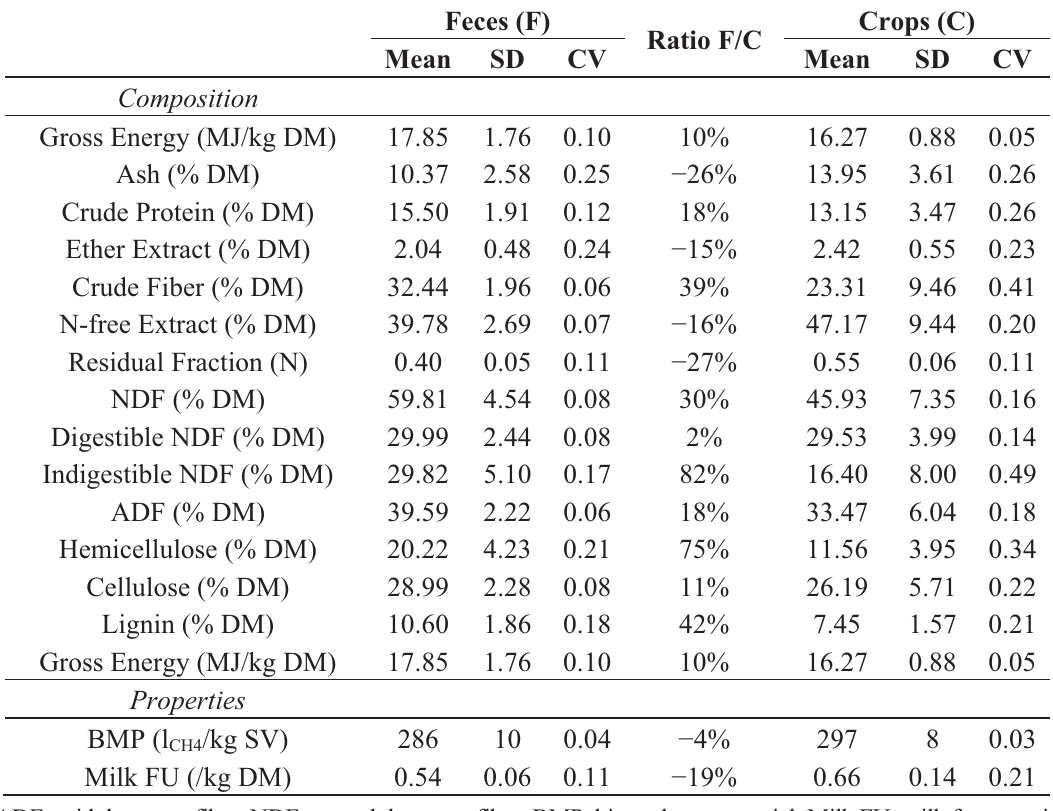
Table 2. Comparative composition and properties of the rabbit feces and the